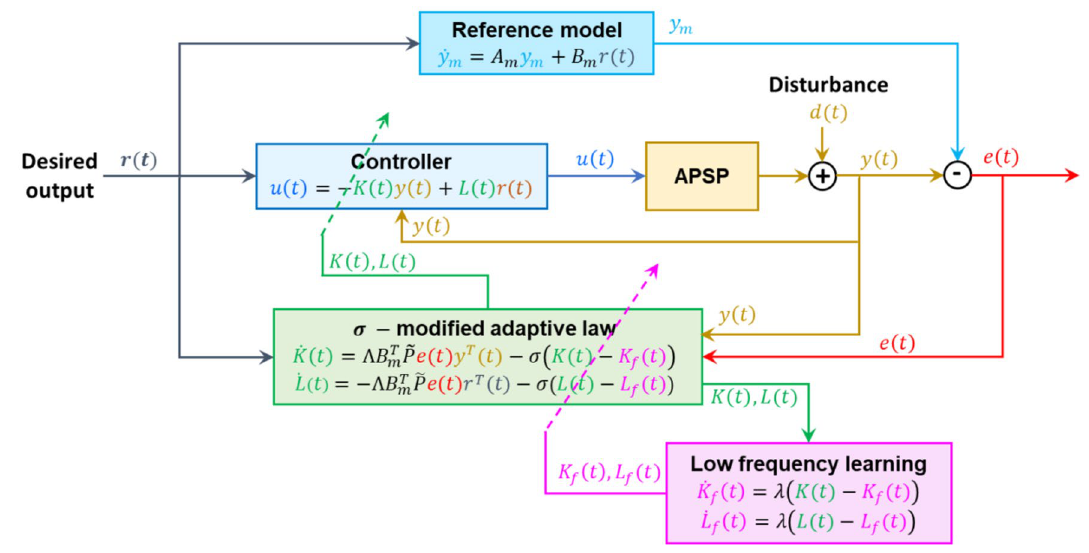
Fig. 4 Schematic of the MR-MRAC architecture Fig. 5 Schematic of the imple- mentation of the MR-MRAC scheme into an